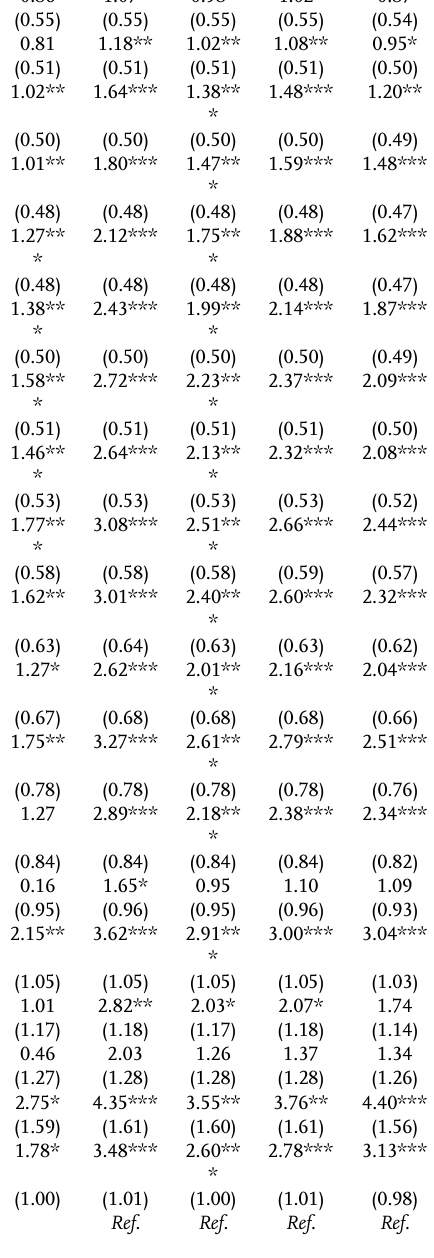
Table A.1 : Earned income, spacing and interaction terms (continued) 19-22 months spacing * first